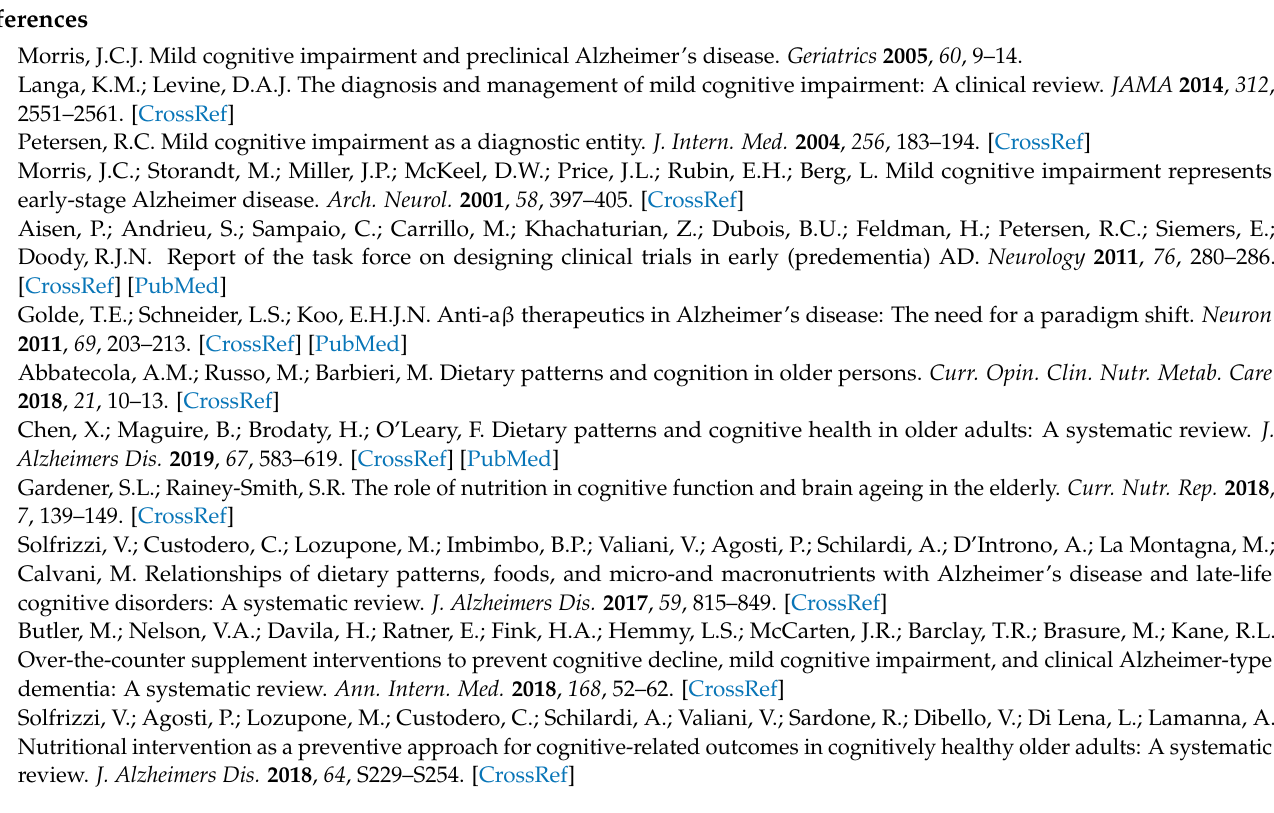
combined composite score, Table S1: Major nutrient intakes and metabolic equivalent values of the SOCE and placebo groups measured at baseline and 12 weeks, and Table S2: Laboratory profiles of the subjects in this